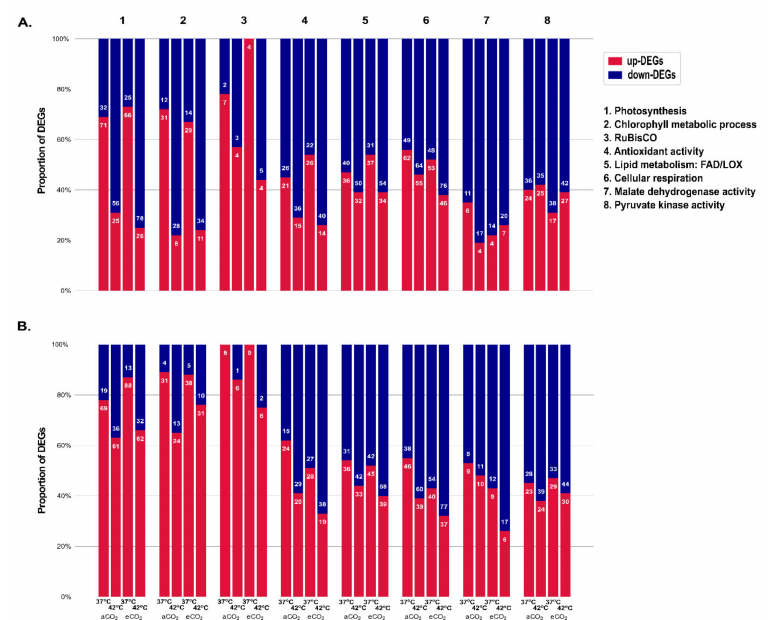
Figure 6. Changes in the proportion of the regulation (%) and in the numbers (indicated in each bar) of differentially expressed genes (DEGs) related to photosynthesis and biochemical processes in Icatu ( A ) and CL153 ( B ) plants, as a response to 37/28 ◦ C (37 ◦ C) and 42/30 ◦ C (42 ◦ C) and grown in 380 µ L L − 1 aCO 2 or 700 µ L L − 1 eCO 2 . The searched gene ontology (GO) biological processes included: “photosynthesis”, “chlorophyll metabolic process”, “ribulose-bisphosphate carboxylase activity” (RuBisCO), “antioxidant activity”, “lipid metabolic process (LOX, FAD)”, “cellular respiration”, “malate dehydrogenase activity”, and “pyruvate kinase activity”, as well as its direct child significant terms.